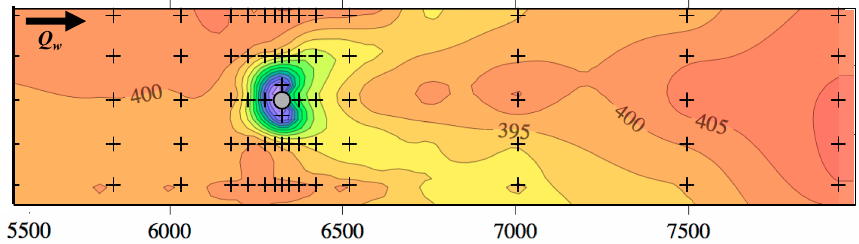
Figure 5. Measuring grid and 2D contour plan of scour for laboratory data for Q w = 0.036 m 3 s − 1 , h 0 = 0.10 m (basing on own laboratory data).